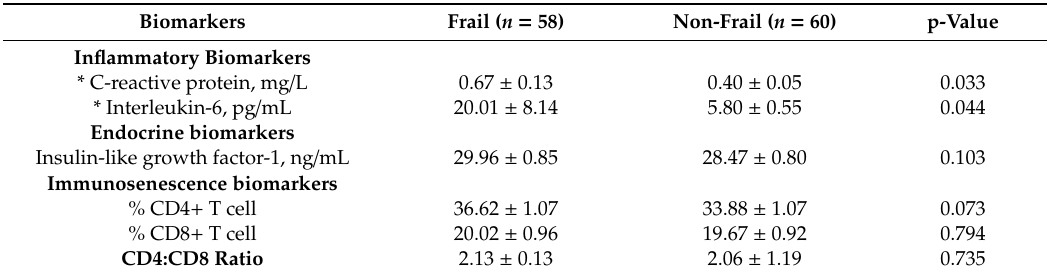
Table 4. Comparisons of blood-based biomarkers between the frail and the non-frail phenotype. Biomarkers